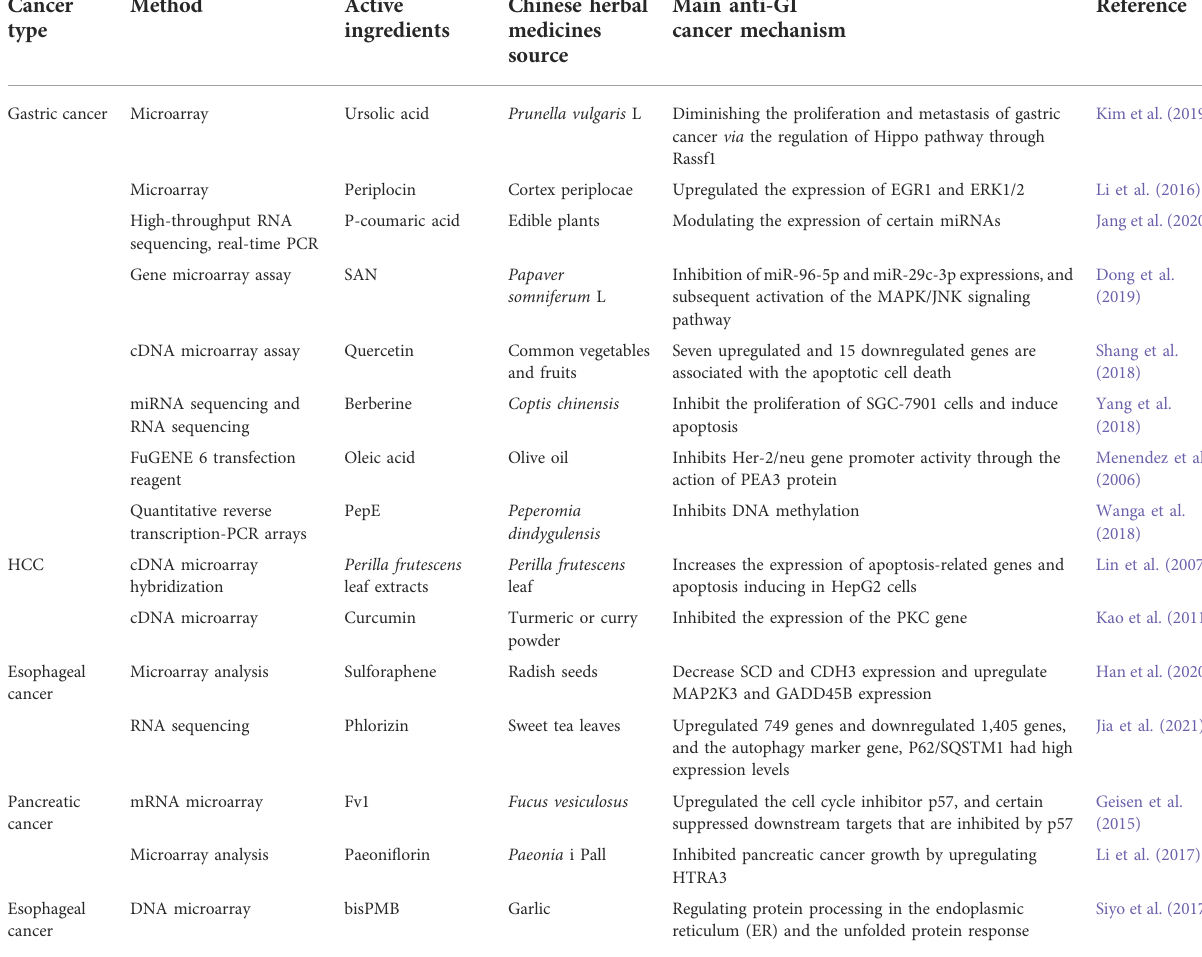
TABLE 1 Applications of genomics approaches for the testing of Chinese herbal medicines in GI